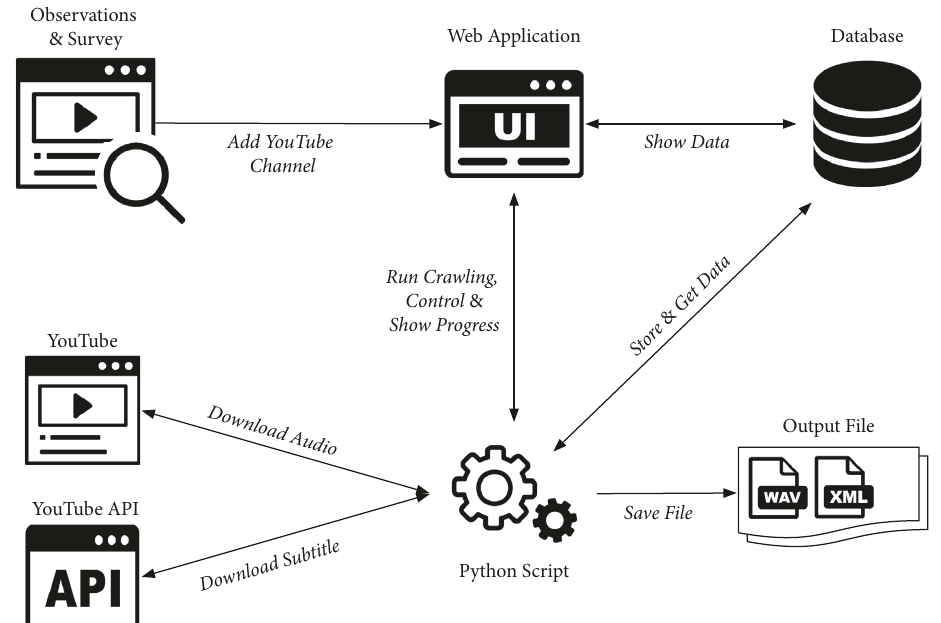
Figure 2: The process of collecting Indonesian audio from the YouTube channel.